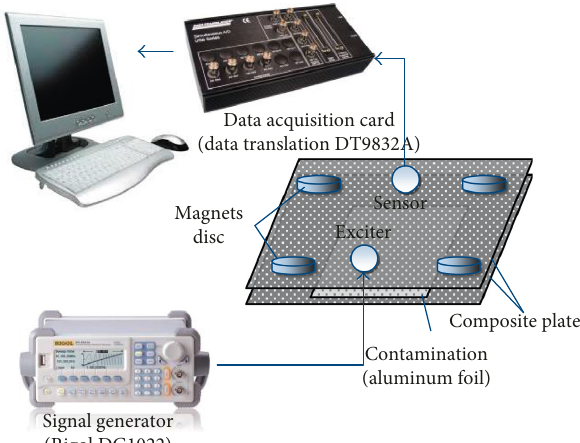
Signal generator (Rigol DG1022) Figure 4: Schematic of the bond inspection in composite plates using the SuRE method.